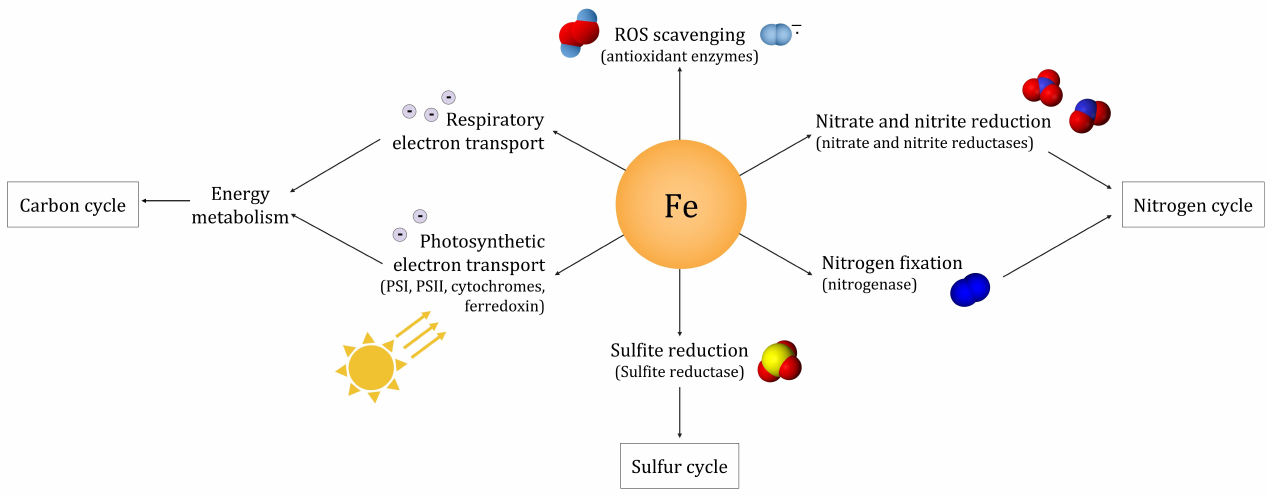
Figure 1. Schematic view of the main processes involving Fe-bearing molecules in marine phyto- plankton, and their large-scale impacts on global